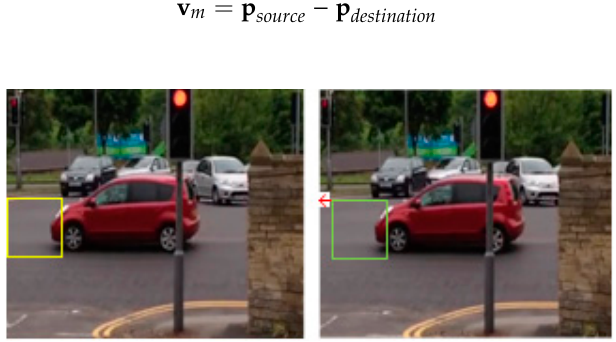
Figure 2. The principle of block motion estimation. Left image: block in current frame marked with yellow rectangle. Right image: best match block in previous frame, marked with green and motion vector marked with red arrow.